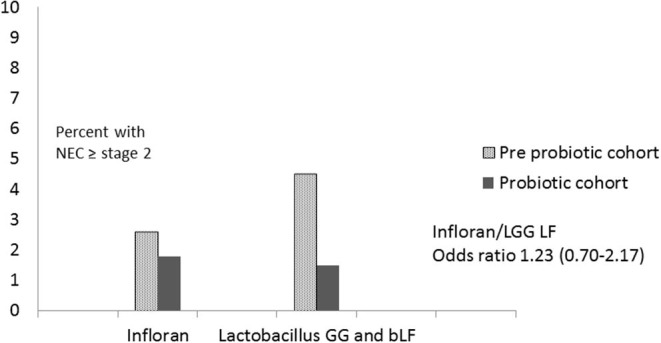
Comparison of Infloran with Lactobacillus GG (LGG) and bovine lactoferrin (bLF) for necrotizing enterocolitis (NEC) in New Zealand level 3 units.